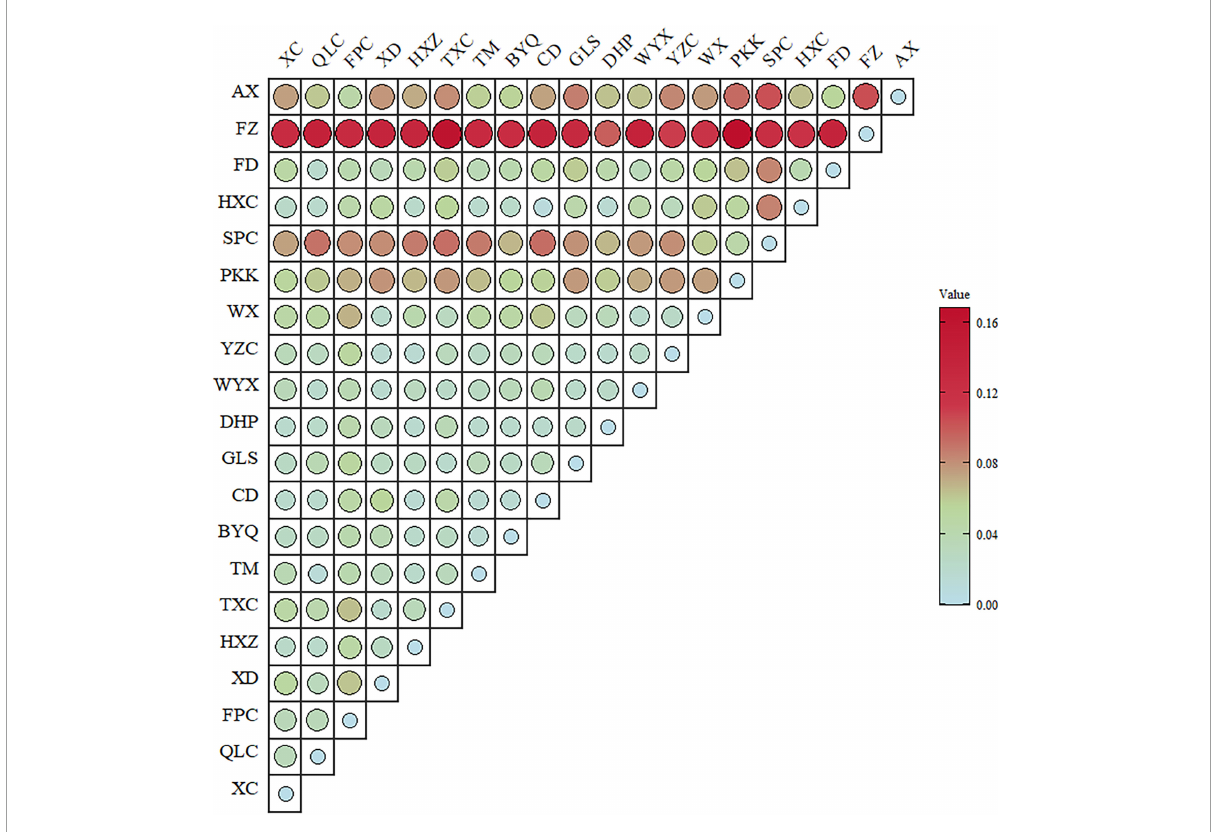
FIGURE1 Pairwise F ST values among the twenty Stethynium empoasca